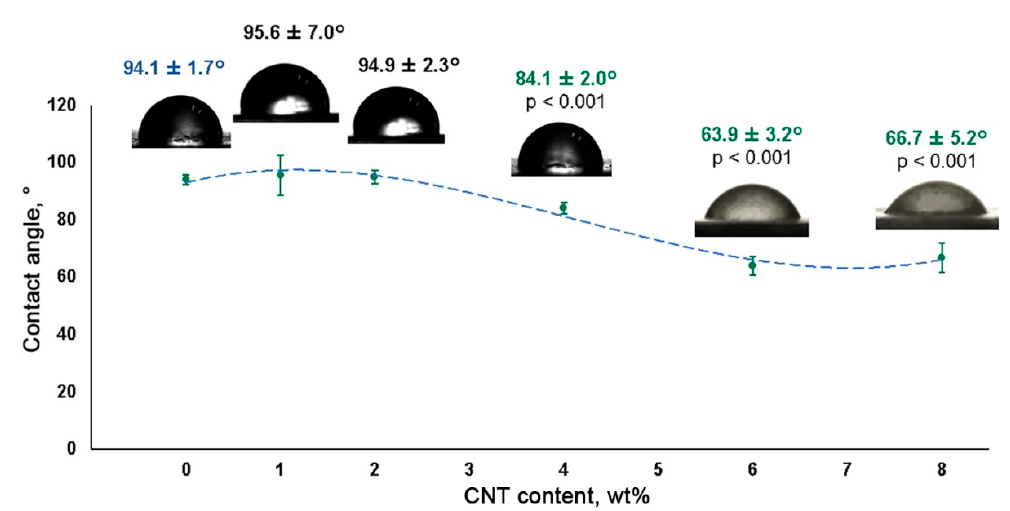
Figure 6. Water contact angles of SIBS–CNT films of different nanofiller concentrations.